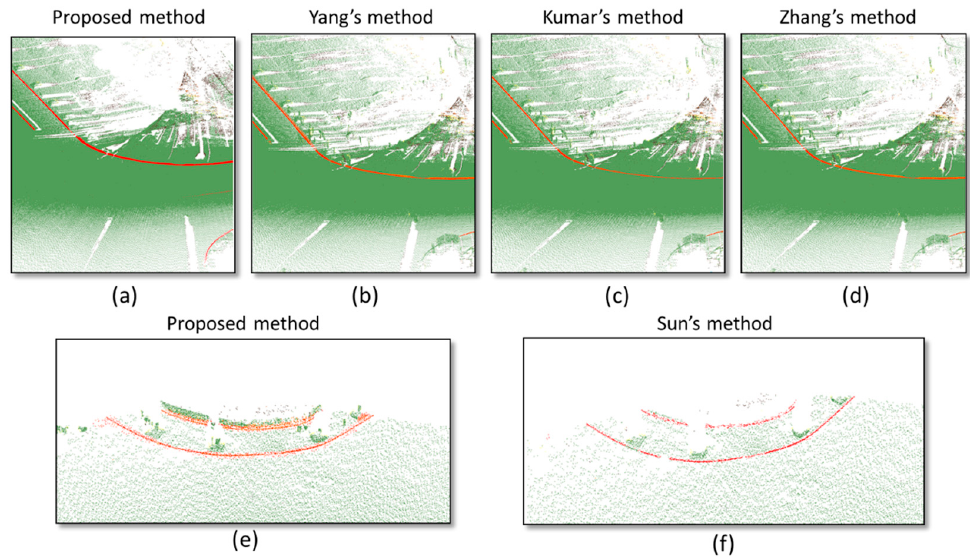
Figure 17. The extraction results compared with other methods. ( a , e ) Proposed method in our study sites; ( b ) Yang’s extraction results in our study sites; ( c ) Kumar’s extraction results in our study sites; ( d ) Zhang’s extraction results in our study sites; ( f ) Sun’s extraction results in our study